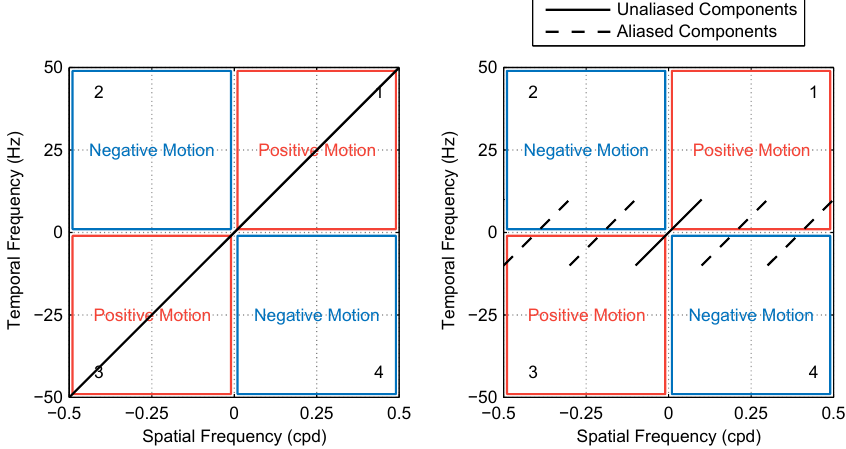
Figure 5. Effect of aliasing on the distribution of motion energy in the Fourier domain. A pattern moving coherently at a constant speed ( v ) has spatial and temporal frequency components along the line f t / f s = v , and its motion energy content is in quadrants 1 and 3 that signify positive motion ( left panel). When the pattern is moved in steps of ∆ x at the same speed, components with temporal frequencies higher than v / ∆ x get aliased and cast towards lower frequencies ( right panel). Aliased components are distributed in the four quadrants, and their net motion energy is therefore close to zero, leaving the energy of unaliased components as a close approximation of what remains in quadrants 1 and 3.